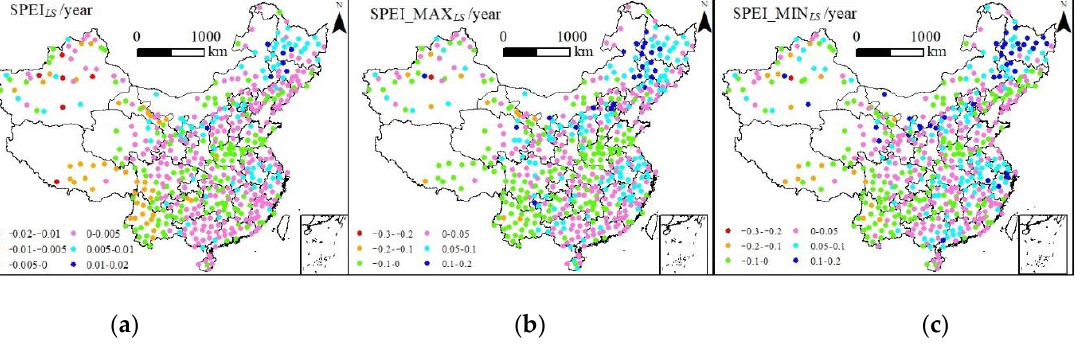
Figure 3. Spatial distribution of SPEI LS ( a ), SPEI_MAX LS ( b ), and SPEI_MIN LS ( c ) in mainland China.